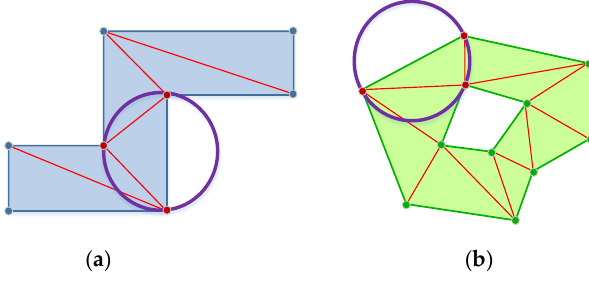
Figure 21. Delaunay triangulation of ( a ) a concave and ( b ) a hollow planar surface.